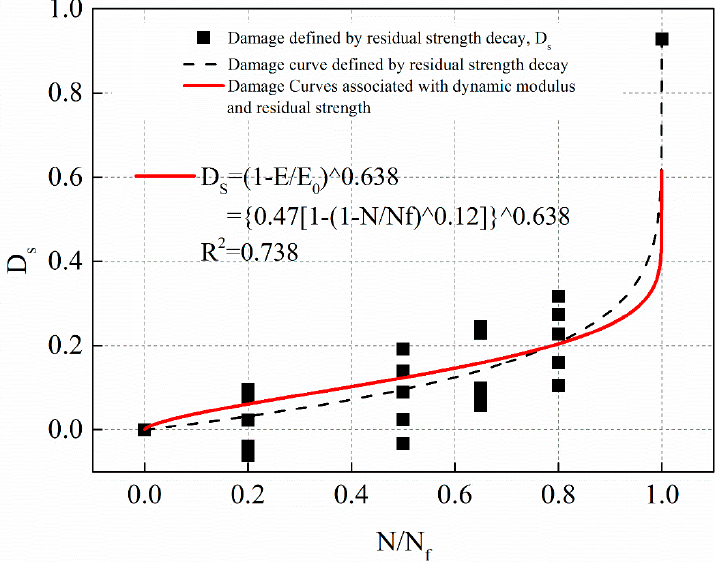
Figure 25. The damage evolution curve associated with dynamic modulus and residual strength with stress levels of 0.25 MPa.